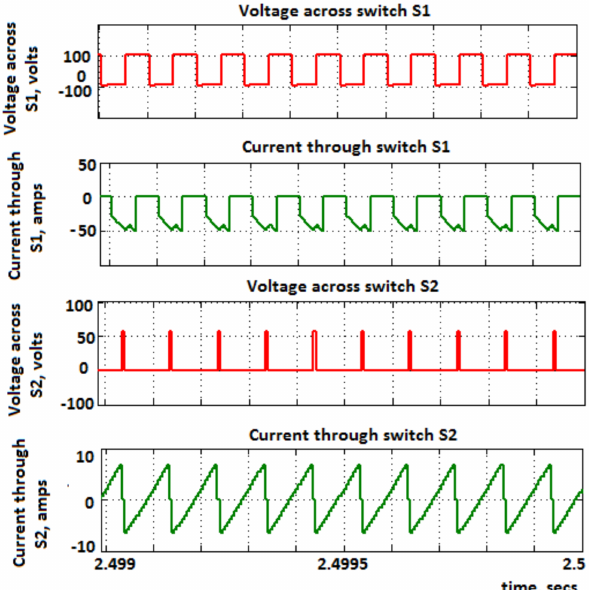
Figure 9. Final switch voltages and currents of S 1 and S 2